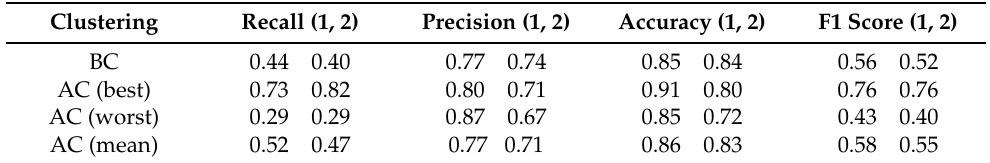
Table 1. Four performance results of RNN with training data type [Genre*ATV]. (In parentheses of the performance metrics, 1 means data set (1) and 2 means data set (2)).